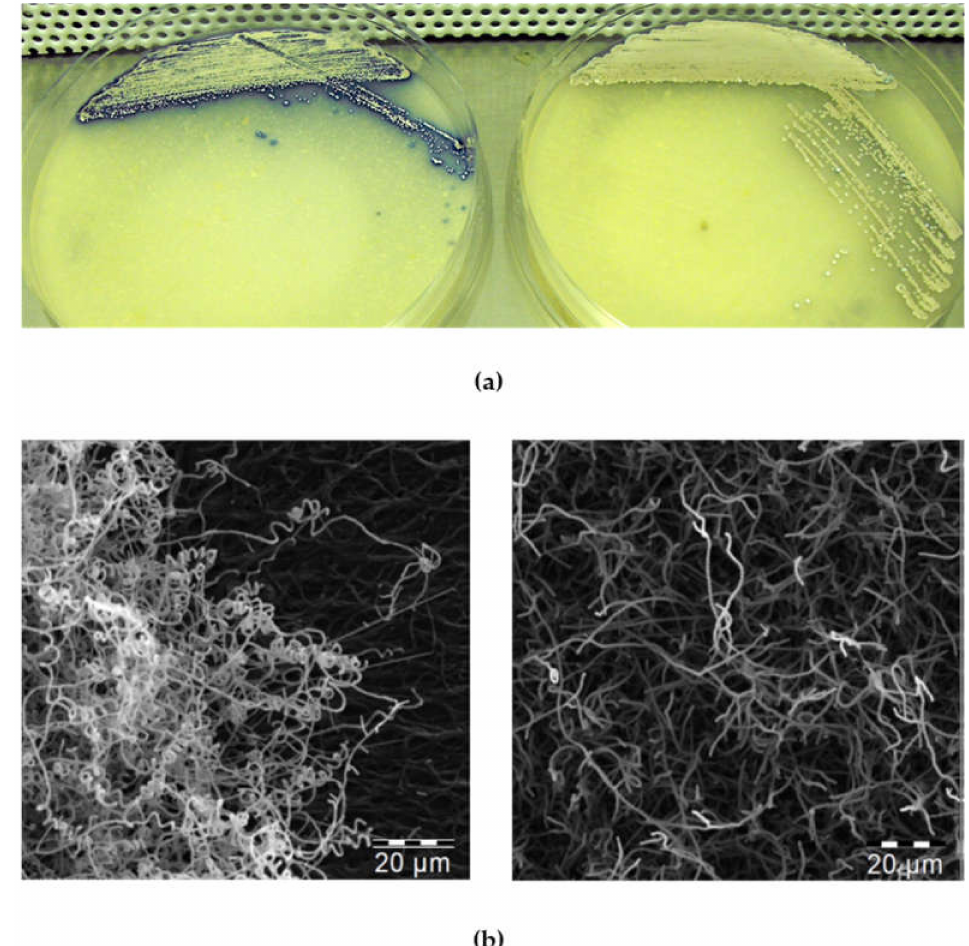
Figure 5. Solid culture phenotypes: ( a ) The C6S (left) and C0 control (right) strains after 120 h of cultivation on MS medium. ( b ) Electron-micrographs of mycelia from the C6S (left) and C0 (right) strains after 120 h of cultivation on solid MS